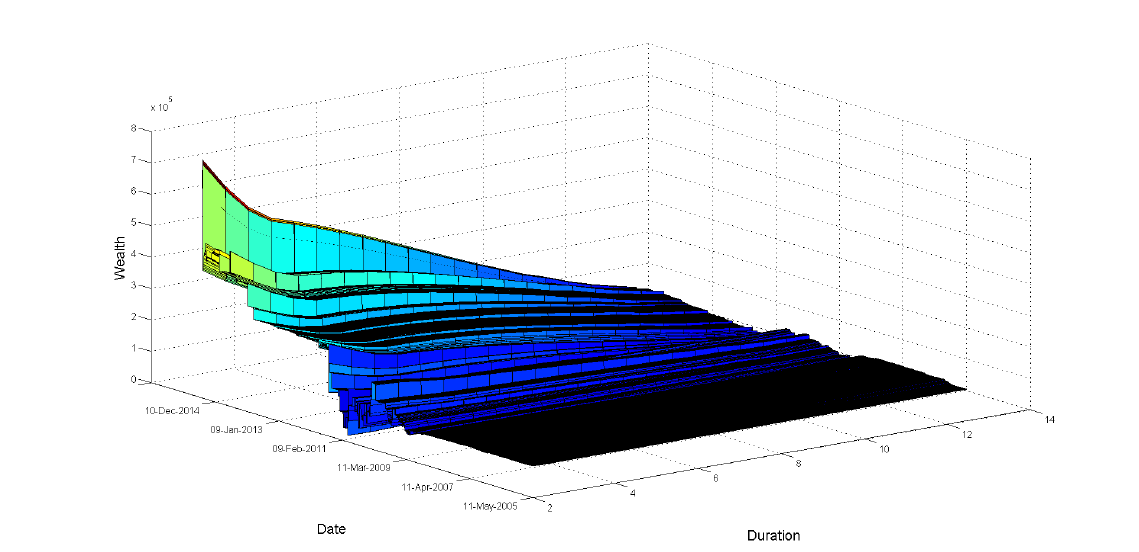
Figure 2. Ex-post wealth on Russian bond portfolios after first phase (May 2011–April